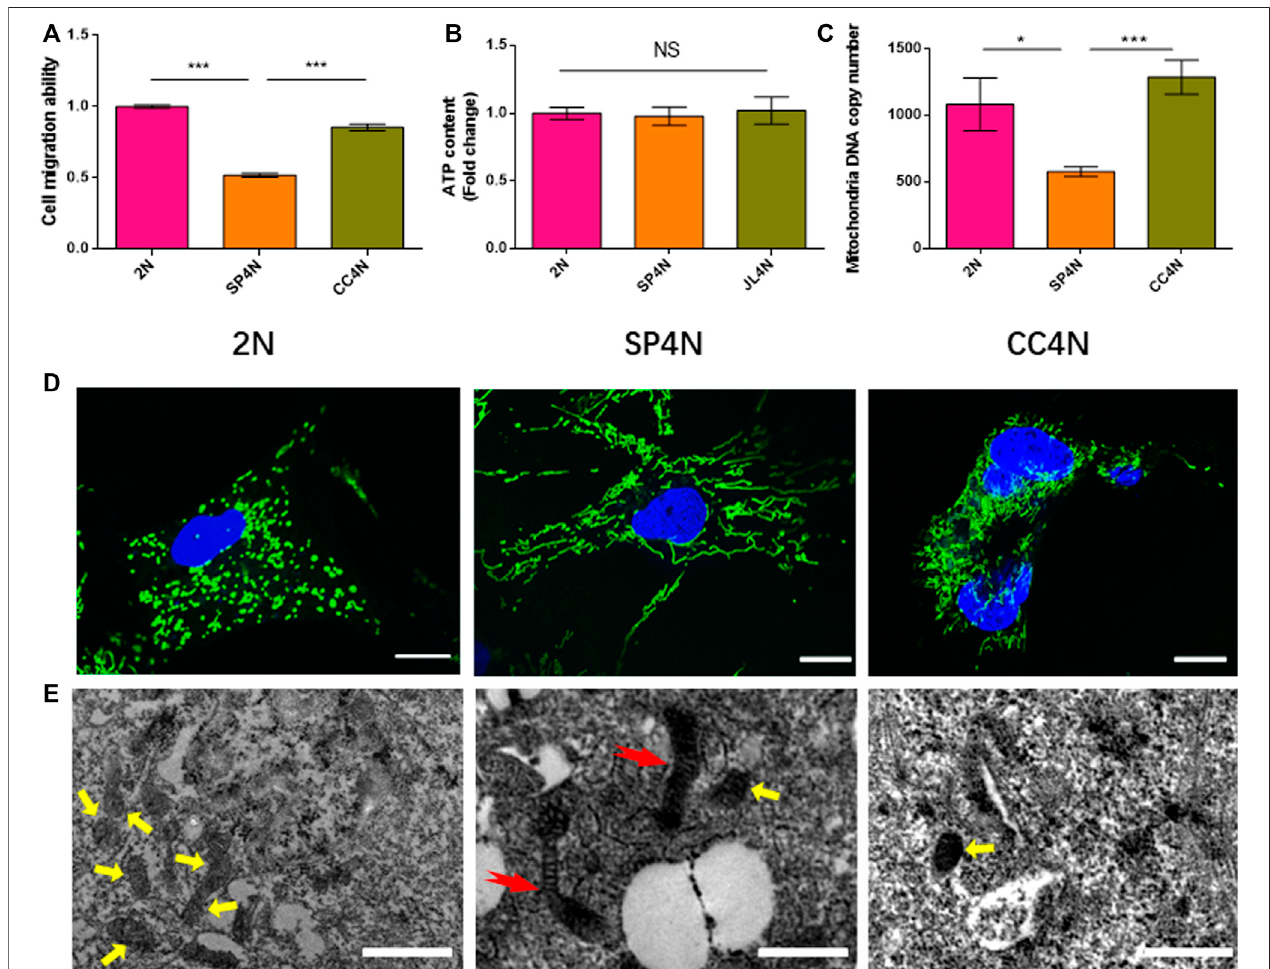
FIGURE 3 | Cell migration ability and observed mitochondria in the SP600125-induced tetraploid cells (SP4N cells), tetraploid cells from C. auratus × C. carpio L. (CC4N cells) and diploid fi sh cells (2N cells). (A – C ) present the cell migration capacity, the ATP contents and the mtDNA copy number, respectively. “ NS ” stands for no signi fi cantdifference,* p ≤ 0.05, ** p ≤ 0.01 and*** p ≤ 0.001representdifferentsigni fi cancelevels of t -test, respectively. (D) presents theobservedmitochondriabylaser confocal microscope. Mitochondria (green) and DNA (blue) were stained with MitoTracker Green FM and Hoechst 33342, respectively. The scale bars represent 10 µm. (E) shown the observed mitochondria by transmission electron microscope, where the scale bars represent 1 µm. The yellow arrows point to small oval mitochondria, and red arrows point to giant mitochondria. DE analysis between SP4N cells and other two cells using